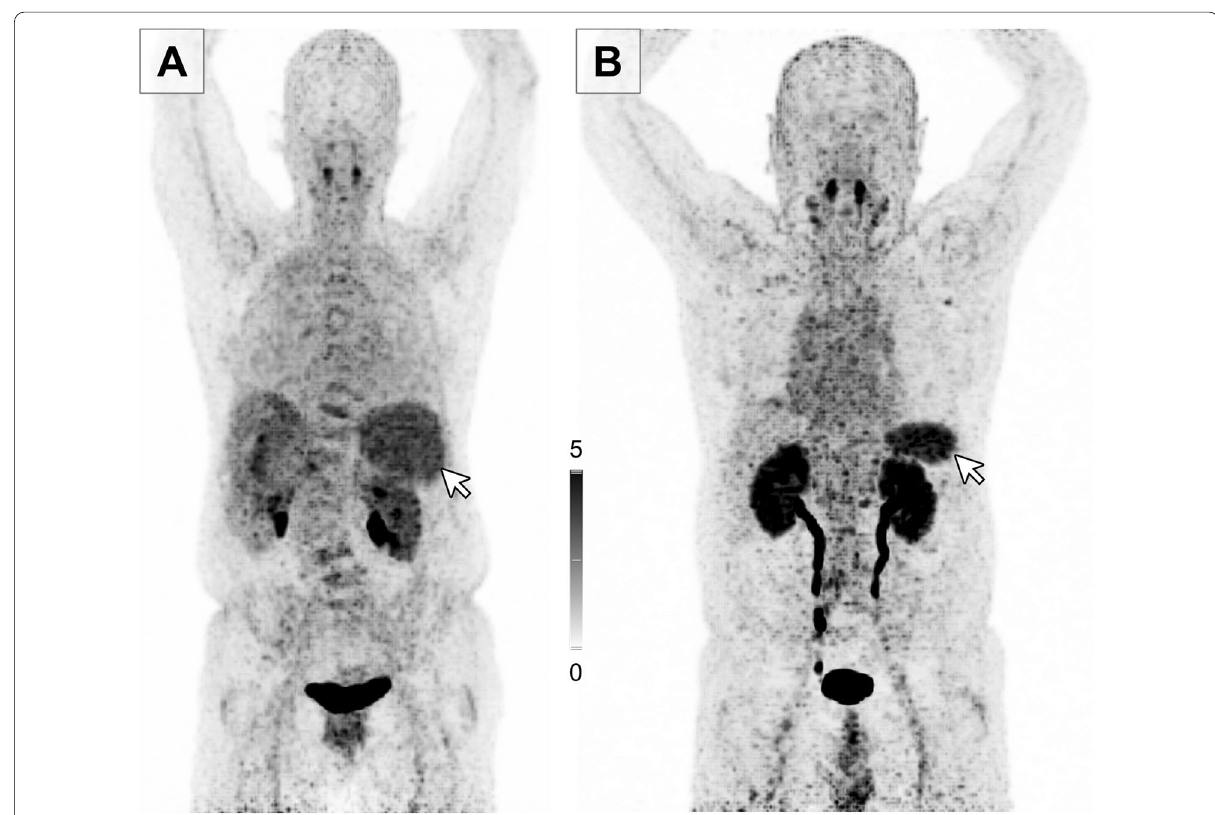
Fig. 1 Patients with solid tumors present with different levels of [ 68 Ga]Pentixafor uptake in spleen. A Representative image of a 68‑year‑old female patient presenting with hepatocellular carcinoma and low spleen CXCR4 expression as measured by [ 68 Ga]Pentixafor uptake. B Representative image of a 68‑year‑old male patient presenting with a neuroendocrine tumor and high spleen CXCR4 expression as measured by [ 68